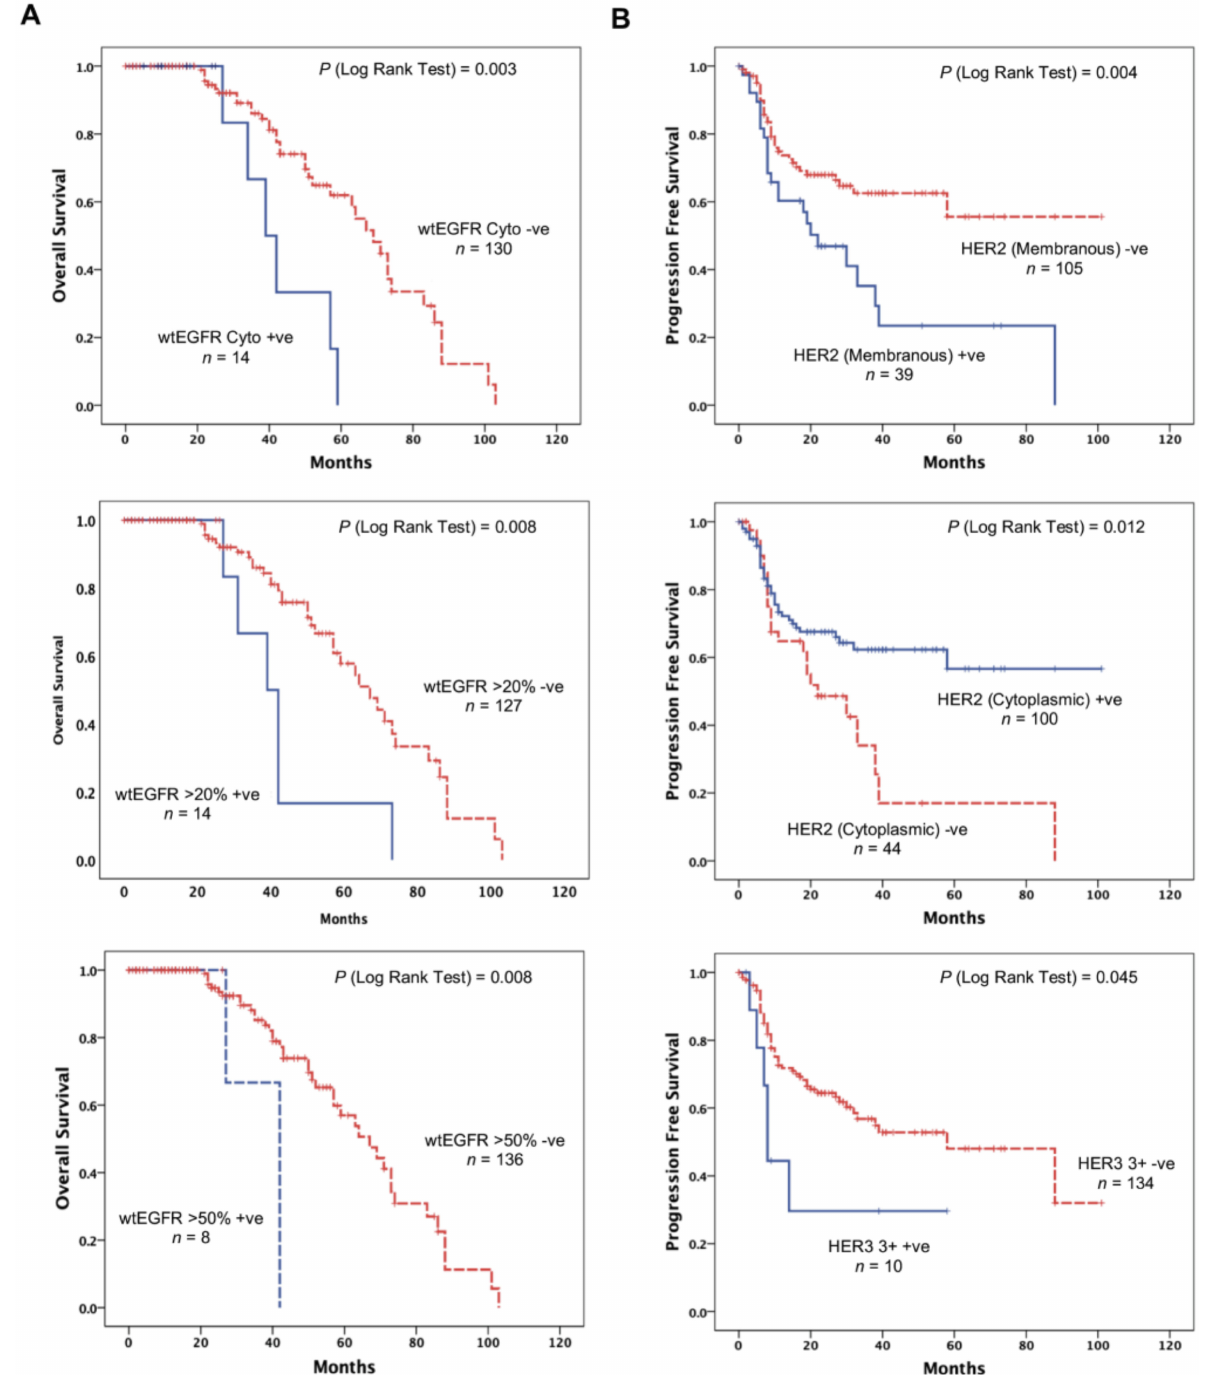
Figure 2. The association between HER family members and OS in mCRC patients treated with cetuximab. Kaplan–Meier survival curves showing the impact on the OS of the patients with localised cytoplasmic wtEGFR expression, wtEGFR expression at >50% cut-off value, and HER4 expression at >20% cut off value ( A ), and impact on the PFS of patients with localised membranous and cytoplasmic HER2 expression, HER3 3+ staining intensity ( B ). A log-rank test value of p ≤ 0.05 was considered statistical